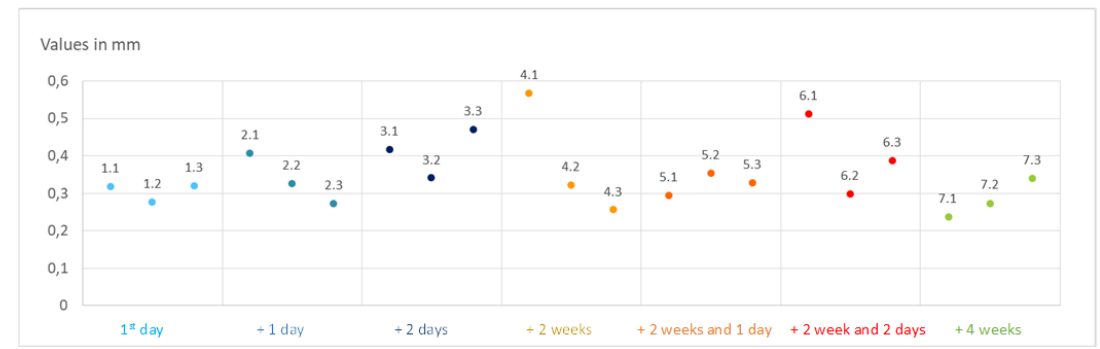
Figure 10. Shape deviation—cone.